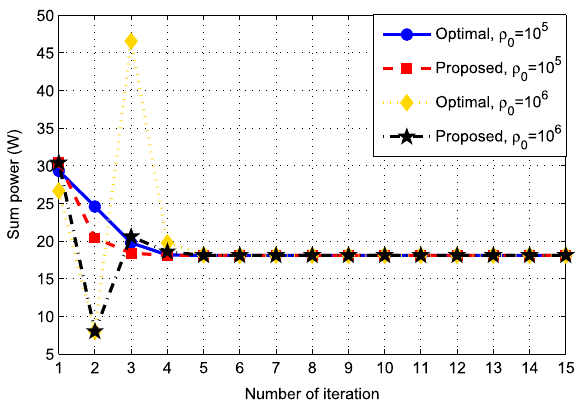
Fig. 6 Sum power of optimal and proposed algorithms for data transmission versus number of iteration